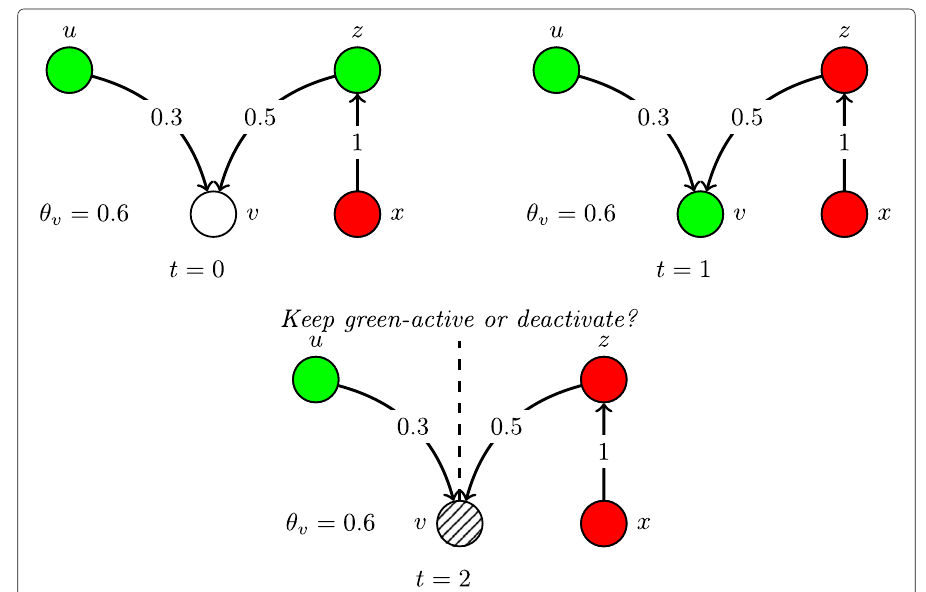
Fig. 3 Uncertainty in an example two-campaign activation